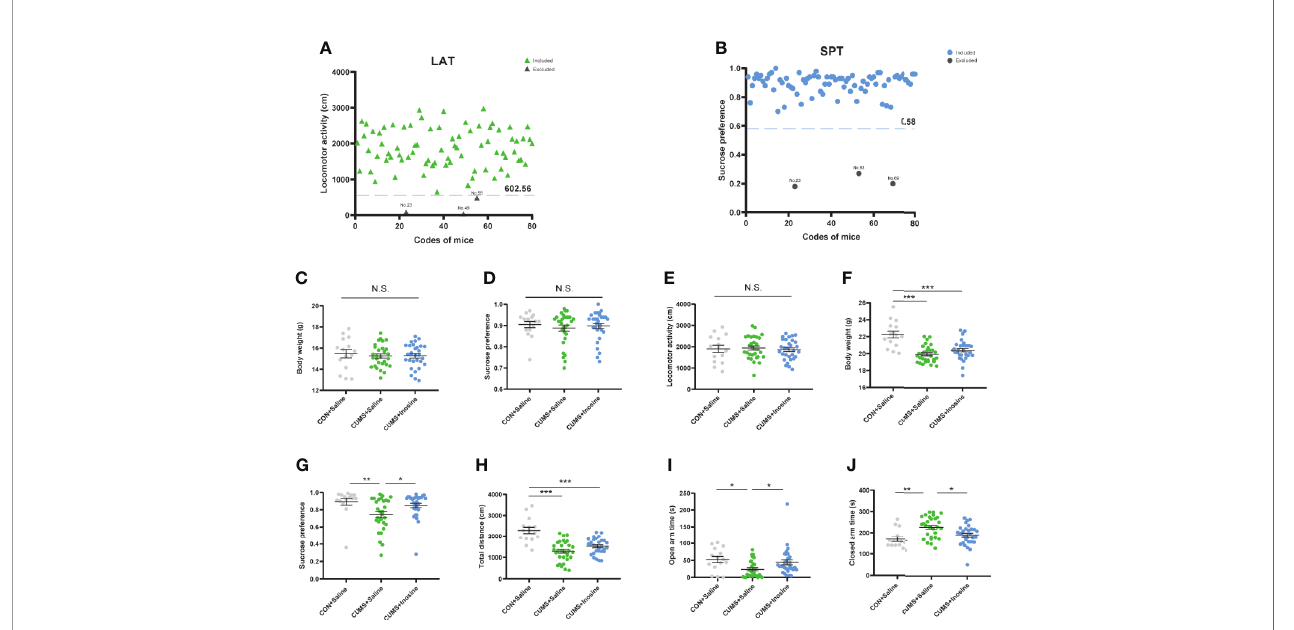
FIGURE 2 | The exclusion criteria of baseline behavioral tests and results of behavioral tests at baseline and end of 4 weeks CUMS exposure. (A) The values below the 95% reference interval in the locomotor activity test (LAT). (B) The values below the 95% reference interval in the sucrose preference test (SPT). (C) The baseline test of body weight. (D) The baseline test of SPT. (E) The baseline test of LAT. (F) The endpoint of body weight. (G) The endpoint of SPT. (H) The endpoint total distance in open fl ied test. (I) The open-arm time in elevated plus maze (EPM). (J) The closed arm time in EPM. Data are presented as means ± SEM. Differences among the three groups were measured by one-way ANOVA and Kruskal-Wallis H -test. p -Value < 0.05 was considered statistically signi fi cant; * p < 0.05, ** p < 0.01, *** p < 0.001 — signi fi cant differences between two groups. ns, no signi fi